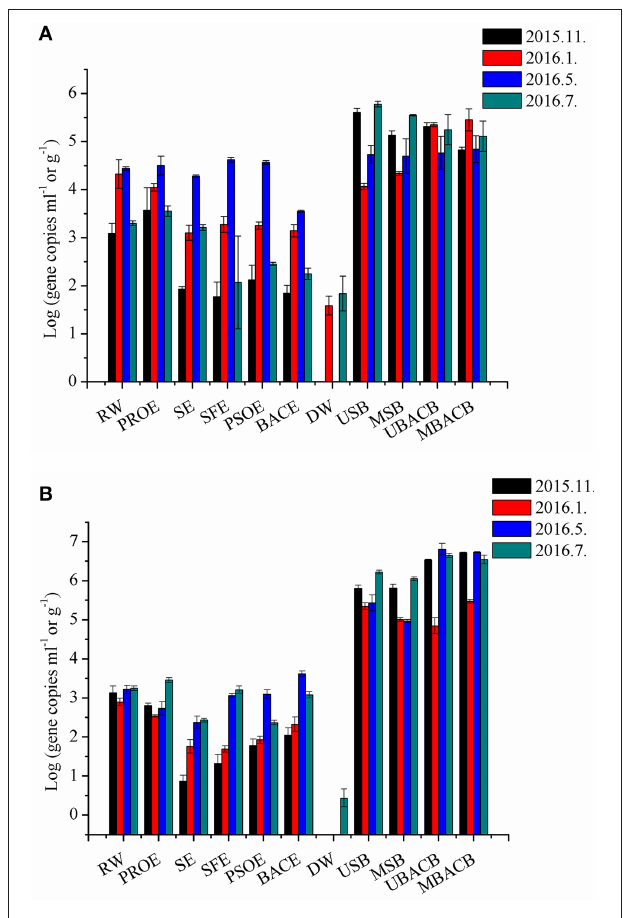
FIGURE 5 | QPCR results for Mycobacterium spp. (A) and Legionella spp. (B) at each treatment step during seasonal sampling. The abbreviations of the samples are the same as used in Table 2 .